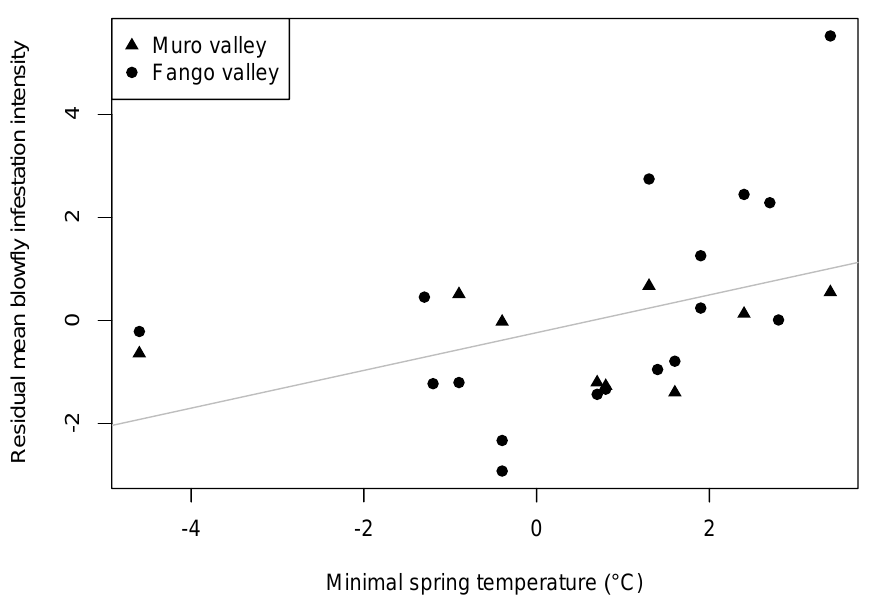
Figure 4. Across years, parasite load (corrected for ambient temperature during nesting) increases with increasing minimal temperatures in early spring ( i.e. during the adult, free-living stage of Protocalliphora blow flies). Dots represent yearly mean